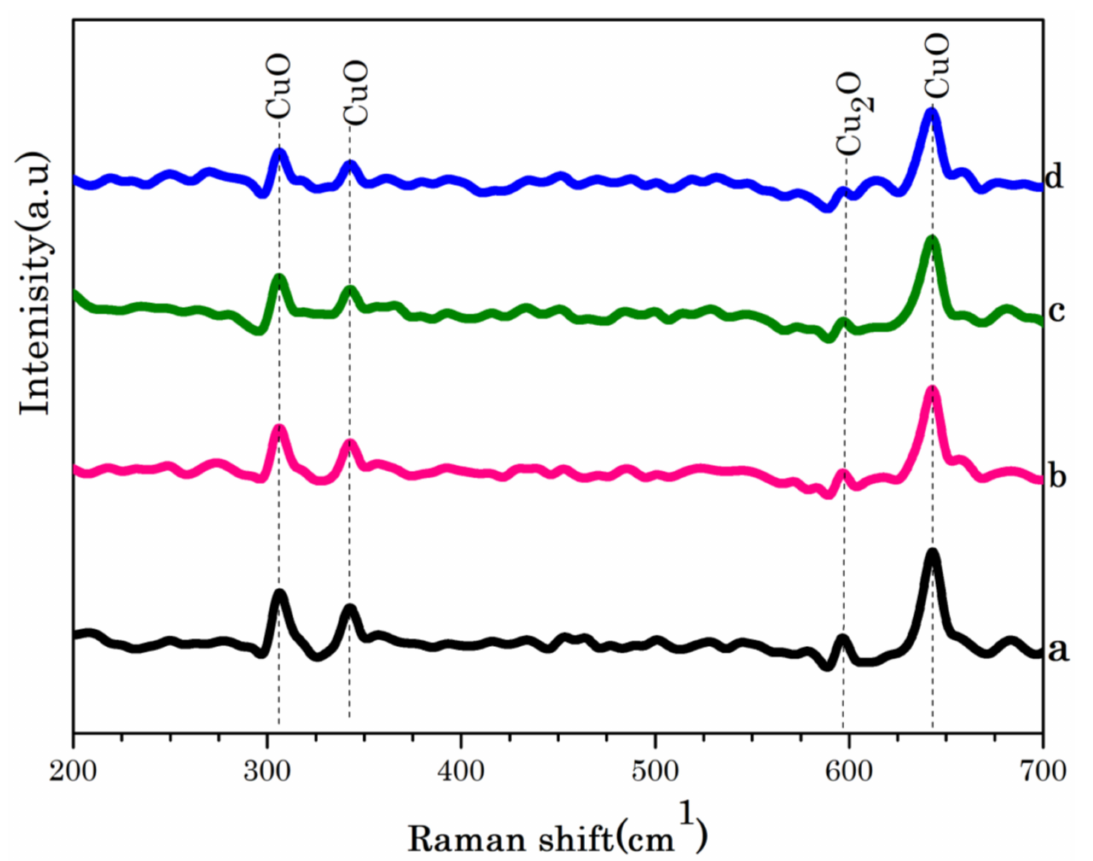
Figure 9. Raman spectra of CuO ( a ) 700 rpm, ( b ) 800 rpm, ( c ) 900 rpm, and ( d ) 1000